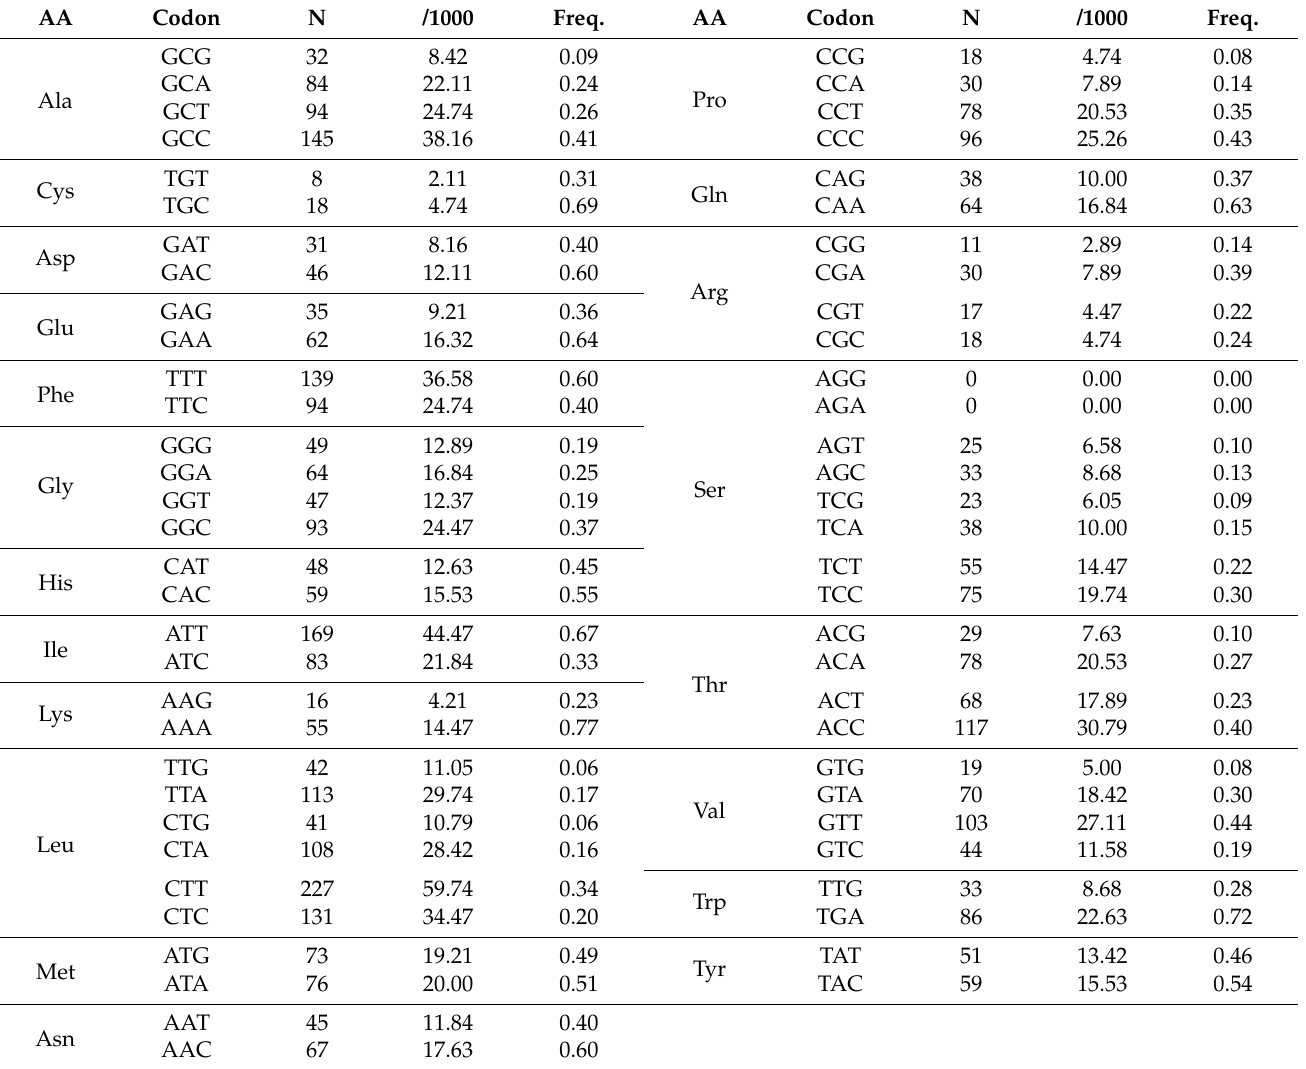
Table 4. Codon usage analysis of PCGs in the mitochondrial genome of C. wui